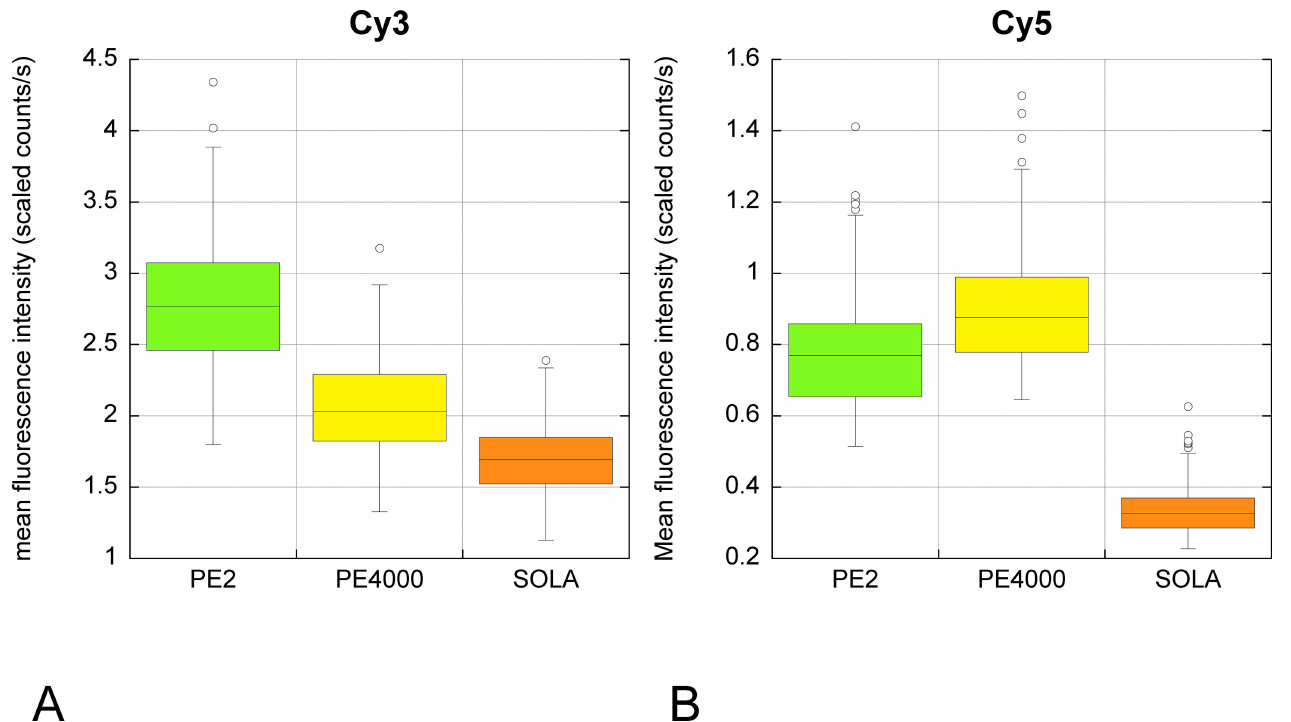
Fig 9. Comparison of unmixed specificfluorescence Cy3 (A) & Cy5 (B) when excitedby whitelightLED (SOLA), PE2 (535nm& 615nm) or PE4000 (555 & 635nm). The same field of view illuminated with the indicatedLED systemwas captured throughthe appropriatefilter(for Cy3 & for Cy5) between500 and 720nm.The fluorescenceintensity (scaledcounts/s)at emissionpeak wavelengths was obtainedafterspectral unmixing. The excitation peaks of Cy3 and Cy5 are 554 & 649 nm respectively. Despitethe LAMs used with PE2 not being the optimumavailable, the resultswere betterthan with the white light